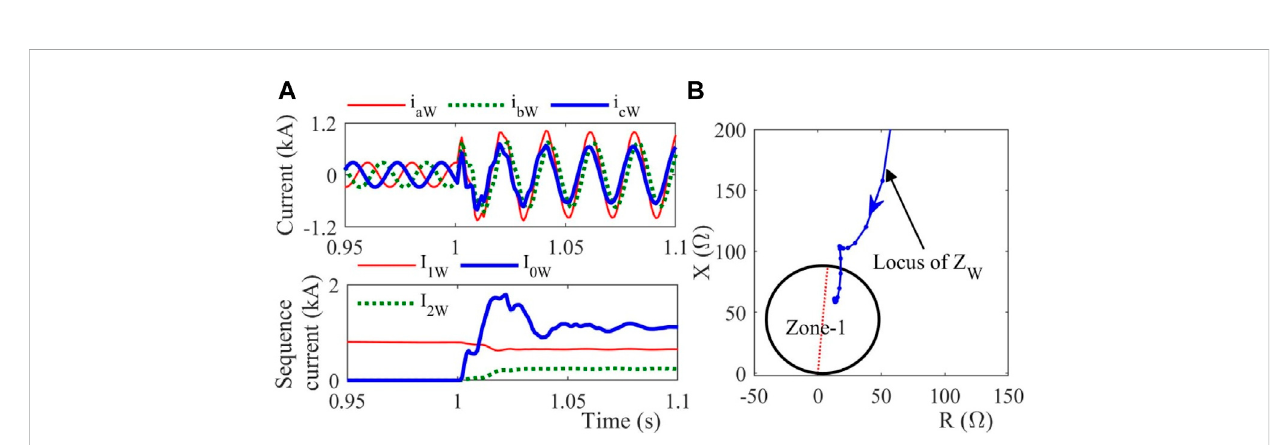
FIGURE 2 Demonstration of the impacts of unbalanced ground faults (cg-type) on relay R W protecting the large-scale DFIG wind farm-connected